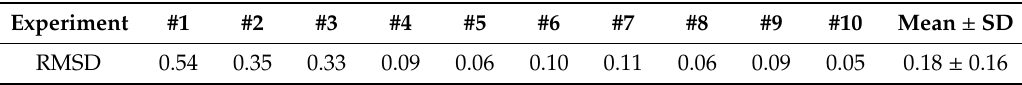
Data are presented in millimeters. RMSD, root mean square deviation; SD, standard